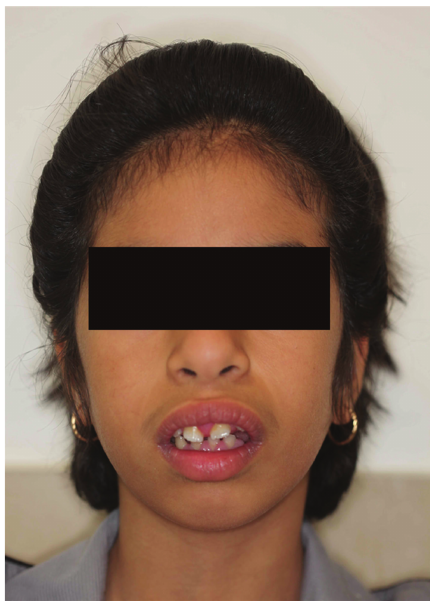
Figure 1: Frontal view of the patient showing lip incompetency and mouth protrusion.